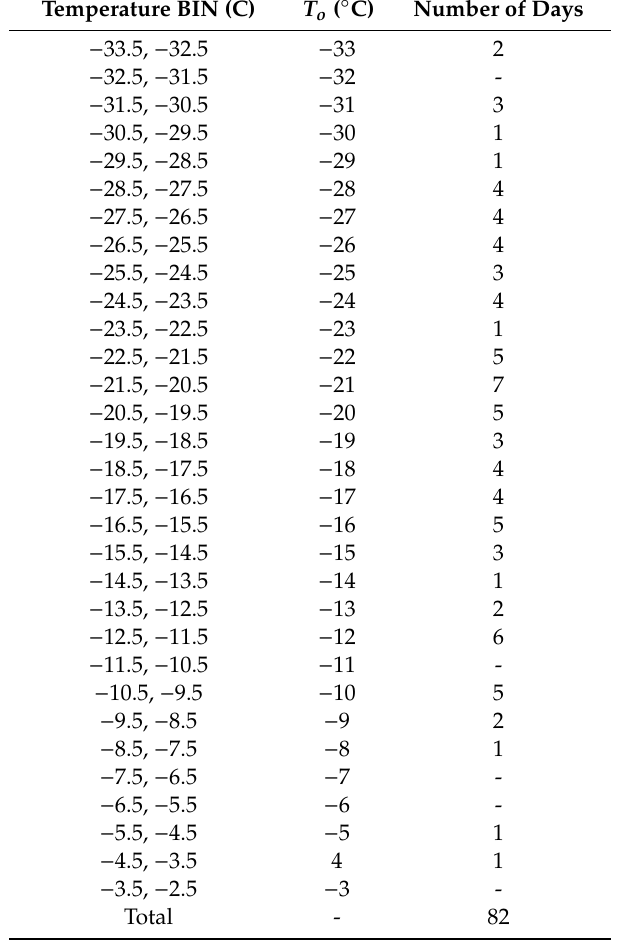
Table 6. Outdoor air temperature bins in Inuvik, NWT, Canada, from January 1 to March 31, 2015.